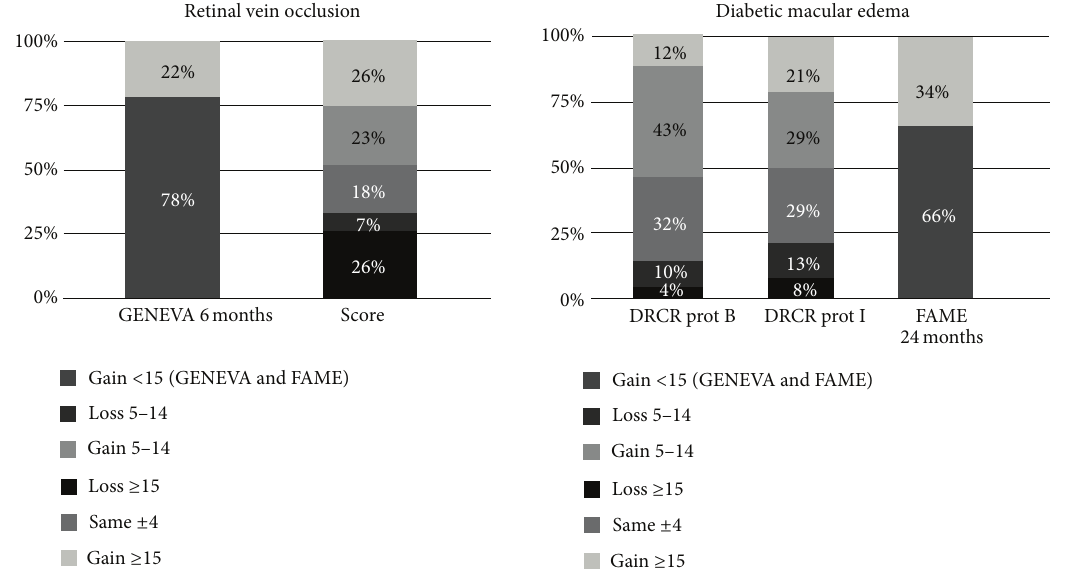
Figure 1: Distribution of change in visual acuity (ETDRS letters) between baseline and month 12 (unless otherwise specified) for large, controlled, and randomized clinical trials investigating steroids in diabetic macular edema and macular edema secondary to retinal vein occlusion. GENEVA (6 months): 700 𝜇 g dexamethasone implant. SCORE: 4mg intravitreal triamcinolone acetonide. DRCR prot B: 4 mg intravitrealtriamcinoloneacetonide.DRCRprotI:4 mgintravitrealtriamcinoloneacetonidepluslaserphotocoagulation.FAME(24months): 0.2 𝜇 g/day fluocinolone implant. GENEVA and FAME publications did not disclose distribution of change other than the percentage of patients showing a ≥ 15 ETDRS letters